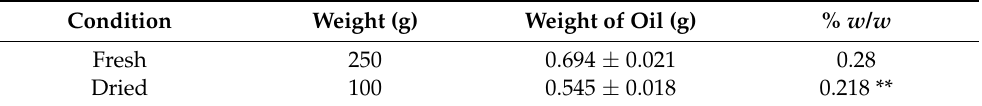
Table 1. Yield of AFO from the fresh and dried plant samples of A. fragrantissima *.